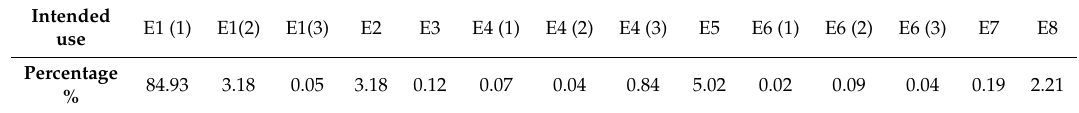
Table 1. Intended use percentage distribution.